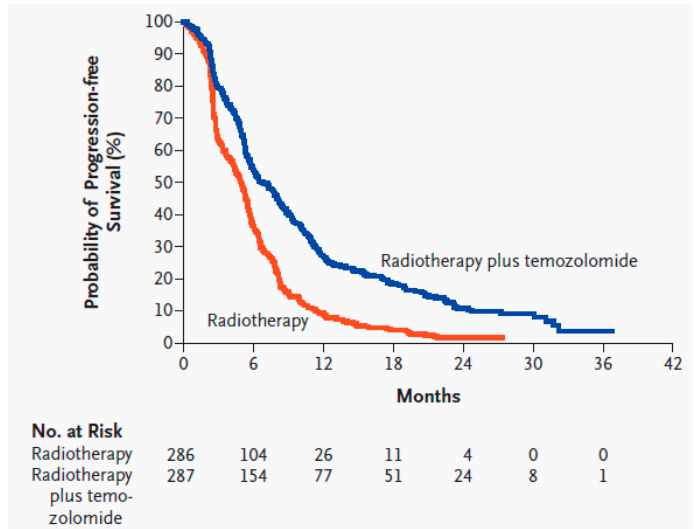
Figure 3. Kaplan–Meier estimates of progression-free survival of glioblastoma patients with radio- therapy alone compared to radiotherapy and temozolomide [5]. Used with permission. Table 3. Progression-free survival (PFS) of glioblastoma patients with radiation therapy alone compared to radiation therapy plus temozolomide [5].